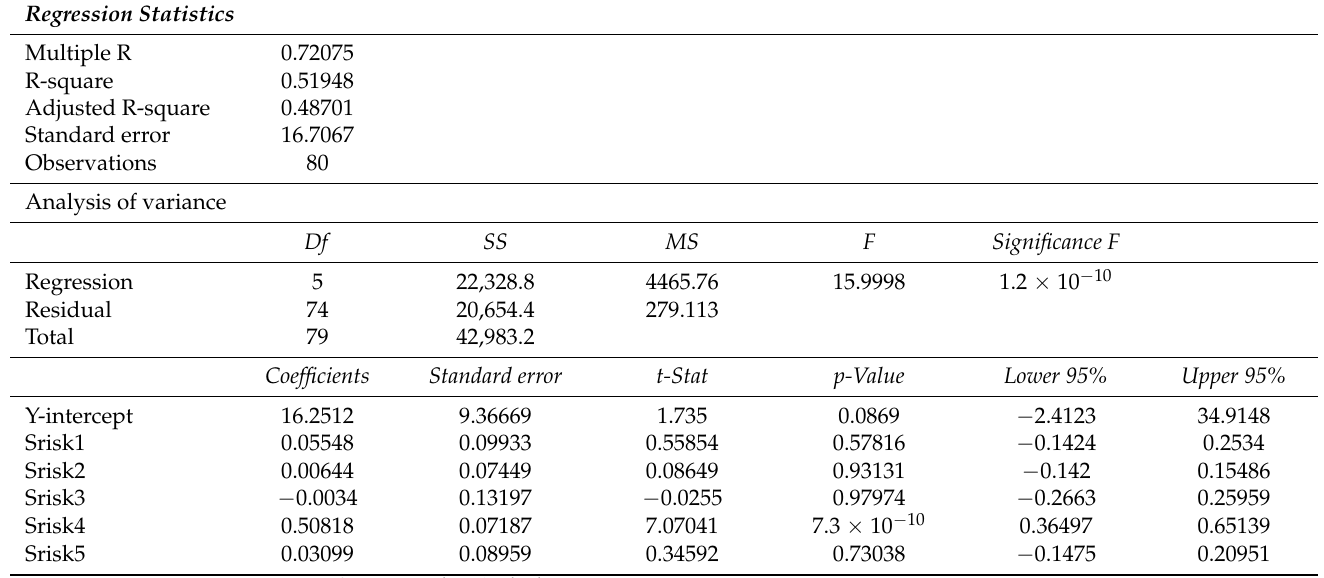
Table A10. Regression statistics of the dependence of Frisk 1 on social consequences of investments in innovation